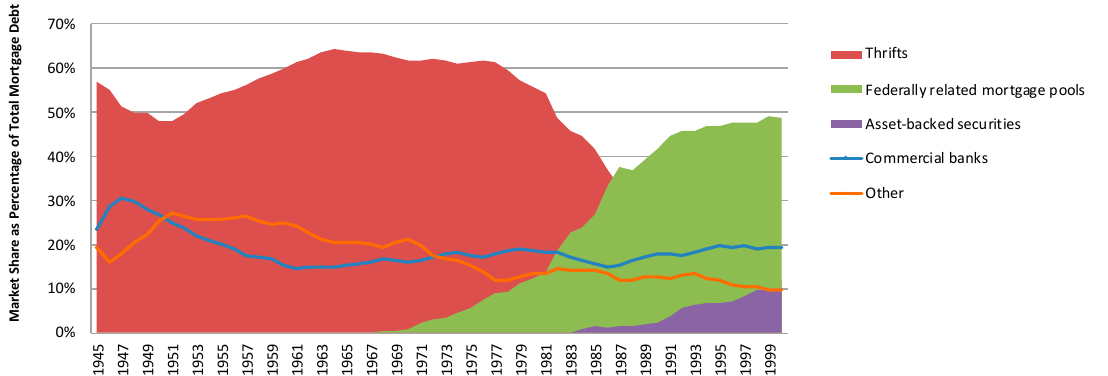
Figure 3. Relative Change in Home Mortgage Market Share. Data source: Federal Reserve Board, Flow of Funds Accounts: Annual Flows and Outstanding’s.